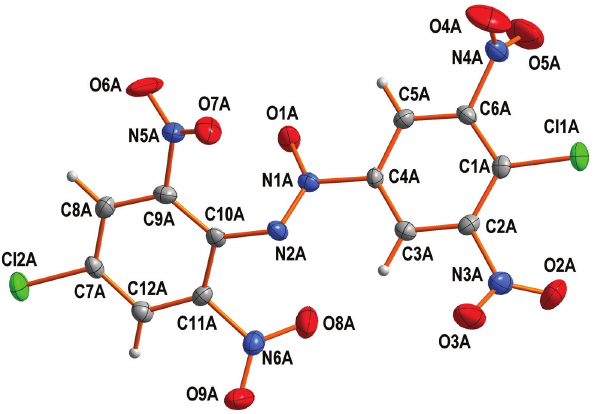
Table 2: Fractional atomic coordinates and isotropic or equivalent isotropic displacement parameters (Å 2